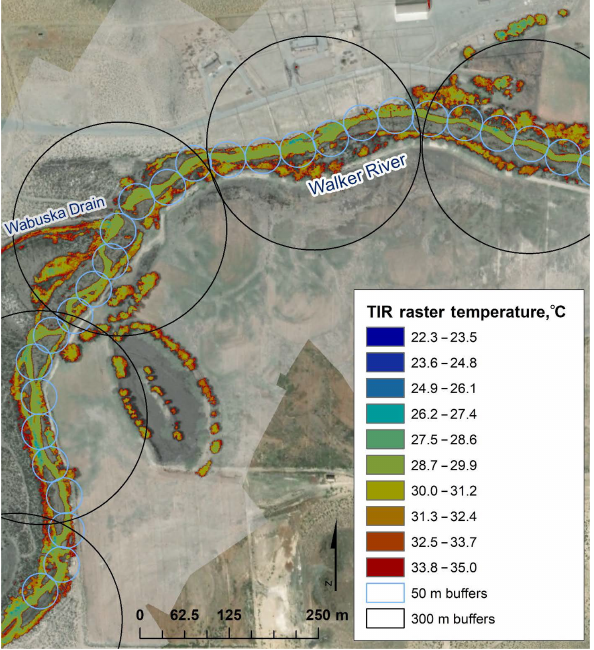
Figure 5. TIR raster data of the main stem Walker River near the Wabuska Drain with 50 and 300m